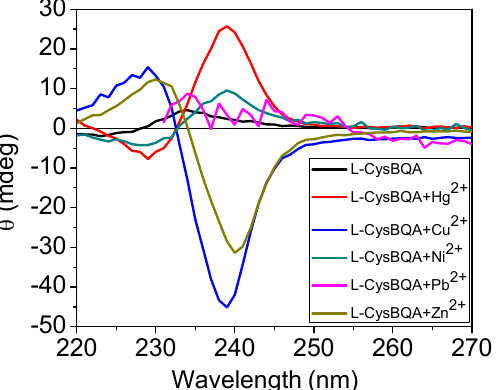
Figure 7. Circular dichroism response of 10  M L -CysBQA to 50  M HgCl and Zn(ClO Reproduced by permission of